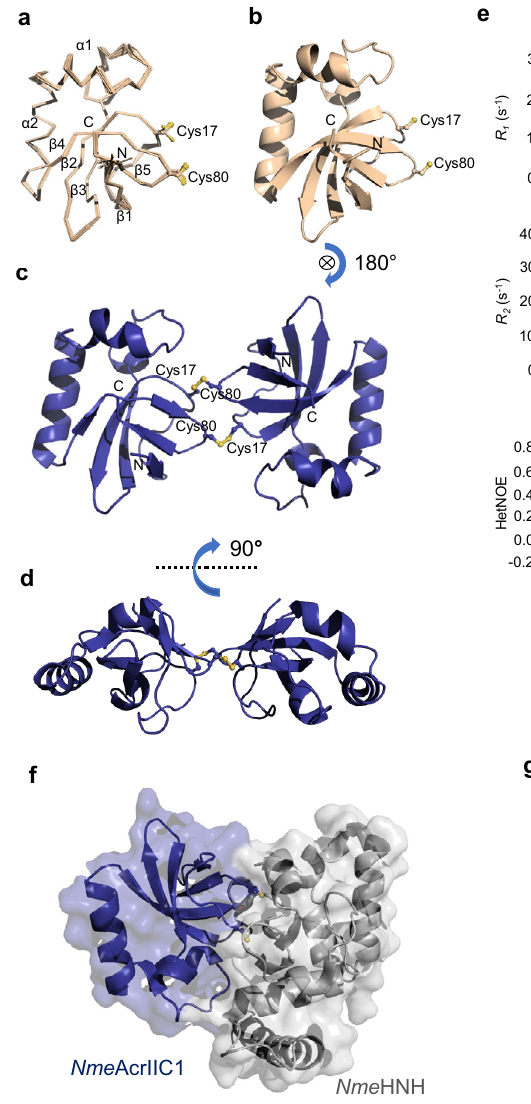
(middle panel), and heteronuclear { 1 H}- 15 N NOE values (bottom panel) plotted as a function of the residue number. Rotational correlation times Τ c were estimated usingaverage R 1 and R 2 usingEq.(1)andlistedinthetablebelow. n =2independent experiments have been performed. Dots represent mean and error bars represent SD. f Surface representation of the complex structure of Nme AcrIIC1 bound to Nme HNH. g Surface representation of the structure for the oxidized Nme AcrIIC1. Residue Ser79, crucial to the recognition of Nme HNH, is highlighted and labeled. Source data are provided as a Source Data fi